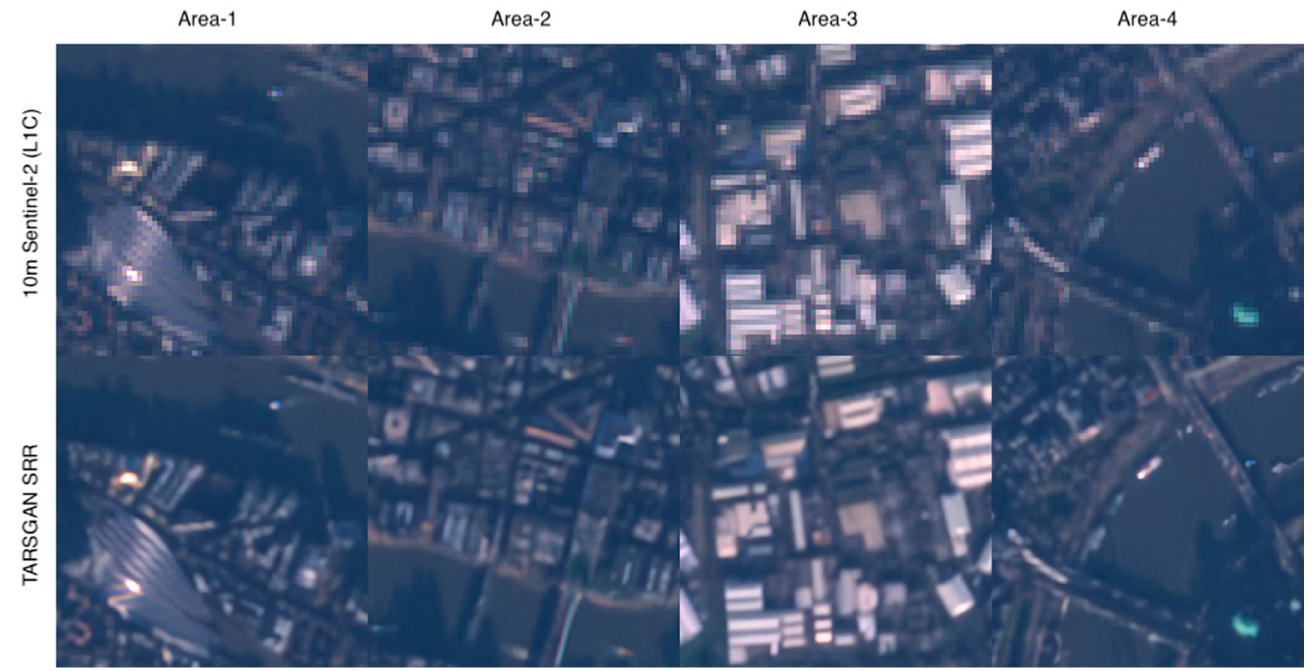
Figure 11. Cropped examples (625 m × 625 m) of the 10 m/pixel Sentinel-2 “true” colour images (L1C) and TARSGAN SRR result over London, UK (Site-4). Please refer to Supplementary Material for full-size SRR (produced from Sentinel-2